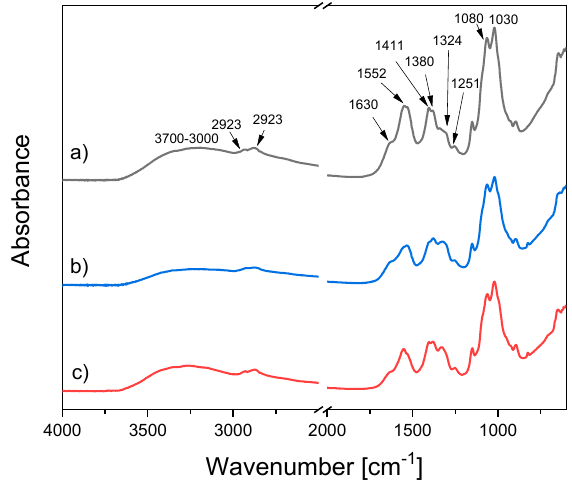
Figure 7. FTIR-ATR spectra of ( a ) blank chitosan and chitosan/Ag NP composites prepared using a plasma-solution system with ( b ) the liquid anode and ( c ) the liquid cathode. Treatment time, 30 min.